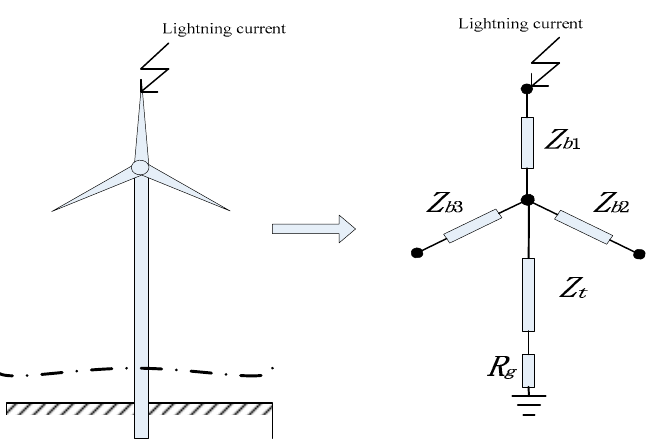
Figure 5. Integrated wave impedance model of offshore WT.